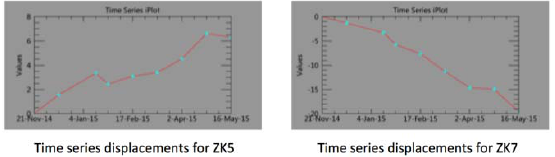
Figure 4. Time series displacements of Boreholes acquired by SBAS technique (Unit of displacement value is